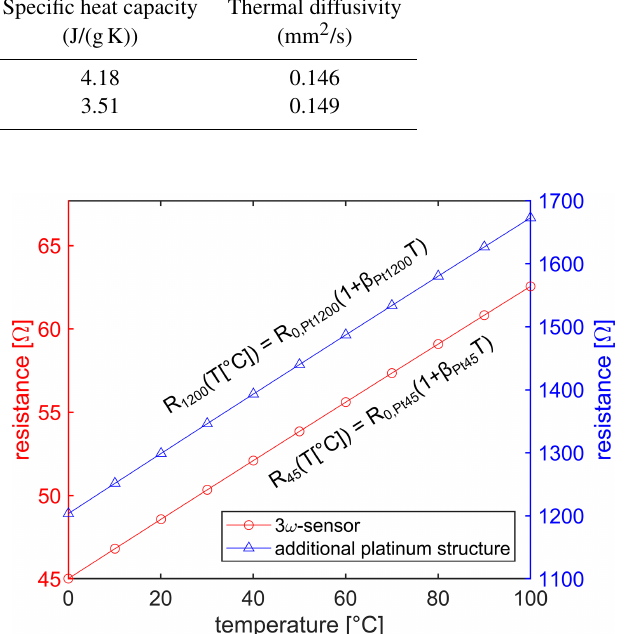
Figure 2. Resistance-to-temperature characteristics for the plat- inum structures. The low-resistance structure has a resistance R 0 , 45 = 45 . 06(1) (cid:127) with a temperature-to-resistance coefficient of β 45 = 3893(6)ppm / K. The high-resistance structure has a resis- tance R 0 , 1200 = 1204 . 7(2) (cid:127) with a temperature-to-resistance coef- ficient of β 1200 = 3896(6)ppm /